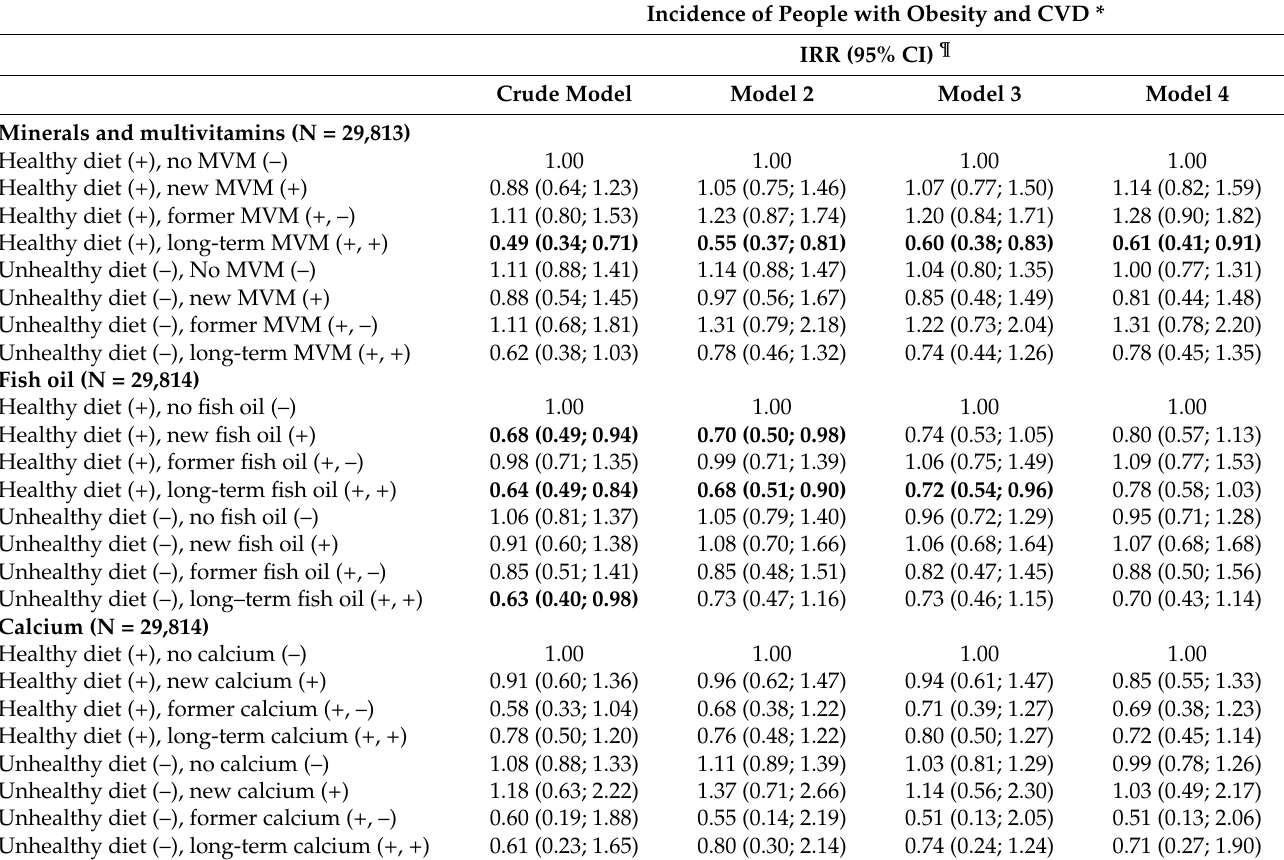
Table 3. The joint effects of healthy vs. unhealthy diet and dietary supplements in relation to the incidence of both obesity and CVD ( N = 29,815